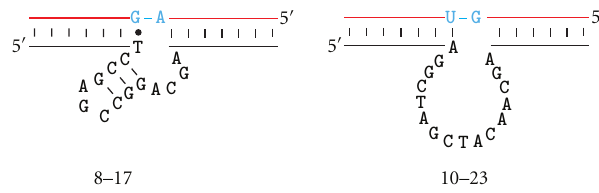
Figure 3: Secondary structures of two best studied RNase DNAzymes: 8–17 and 10–23. The RNA substrate strands are shown in red and the reaction centers are shown in blue. Both 10–23 and 8–17 bind their RNA substrates by two-binding arms made of short Watson-Crick duplexes, which are simplified as line drawings.